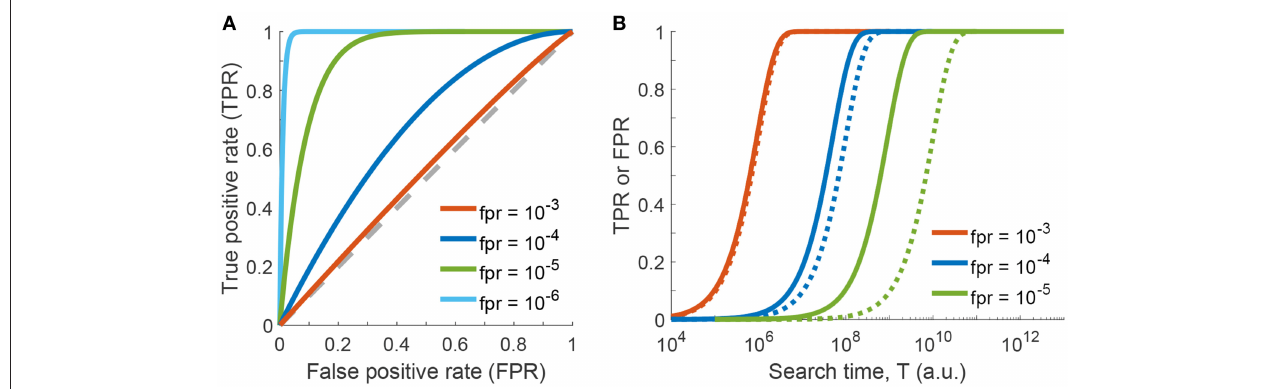
FIGURE 3 | One-phase search strategy, considering errors in classification of individual haybales. (A) Receiver operating characteristic (ROC) curve showing the global true positive rate TPR as a function of the global false positive rate FPR (see Equations 5 and 8 of Supplementary Information ). Curves were calculated for p = 10 − 4 and various values of local false positive rates fpr by varying the parameter n (the number of checked haybales). The line of no discrimination, i.e., where the test has no discriminative power, is shown as dashed gray line. (B) Global true or false positive rates as a function of search time T (see Equation 16 of Supplementary Information , 1 t = 1) are shown for various values of local false positive rates fpr . Global true positive rates ( TPR ) are shown as solid lines, global false positive rates ( FPR ) as dotted